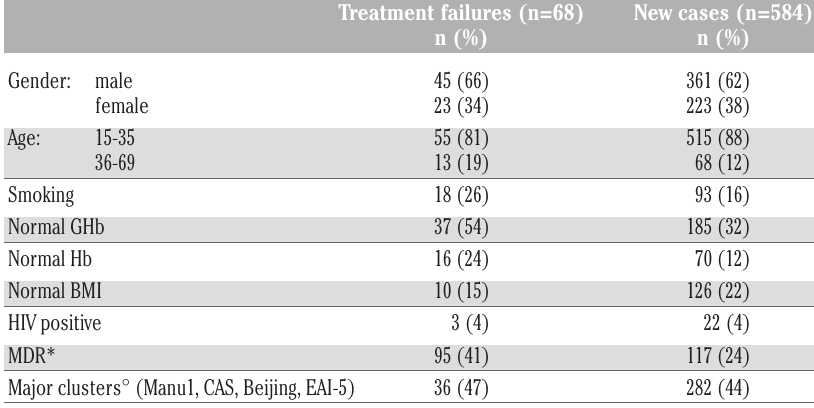
Table 1. Sociodemographic. clinical and biological characteristics of